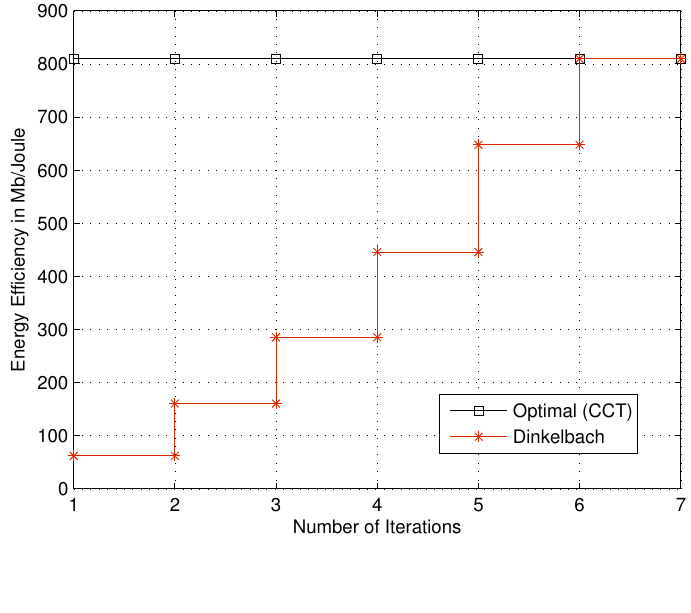
Figure 12. The convergence of Dinkelbach method. Energy efficient vs. number of iterations for transformed concave and parametric Dinkelbach